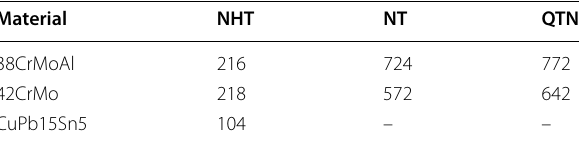
Table 3 Surface hardness of the lower sample (HV)